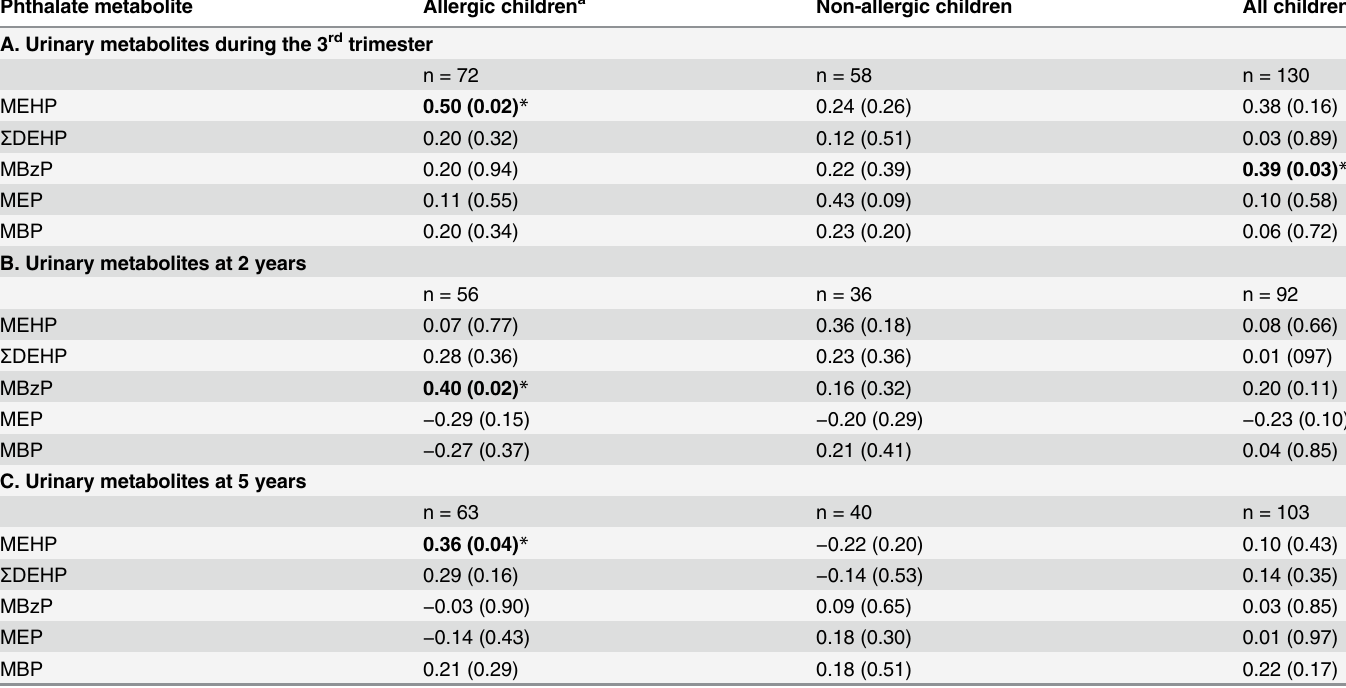
Table 4. Association between maternal and children ’ s log-transformed urinary phthalate metabolite concentrations ( μ g/g creatinine) and log- transformed total serum immunoglobulin E levels (IU/ml) in 8-year-old children. Phthalate metabolite Allergic children a Non-allergic children All